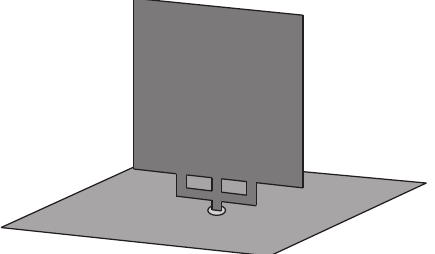
Figure 10: A planar metal plate monopole antenna employing a trident-shaped feeding network [28]. The multipoint excitation is used to increase the amplitude of vertical component of the surface current excited in the monopole. Dark gray monopole and medium gray ground plane.